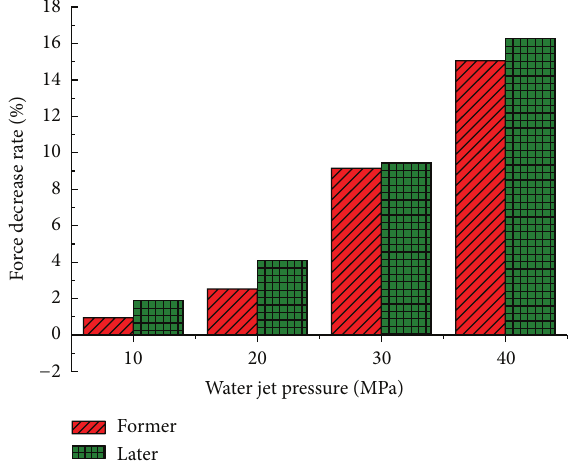
Figure 15: Cutting force decrease rates for combined pick.